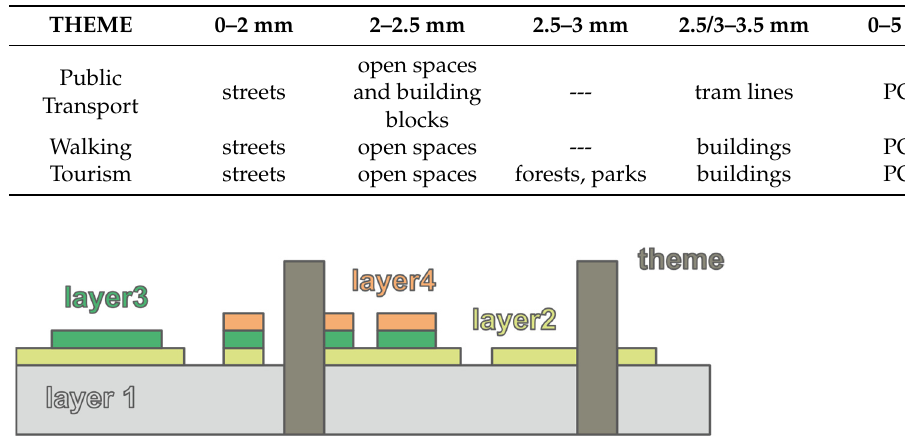
Figure 9. Layer distribution on an example map of Tourism type (layer 1 = streets, layer 2 = open spaces, layer 3 = forest and parks, layer 4 = buildings, theme = thematic layer of POIs).